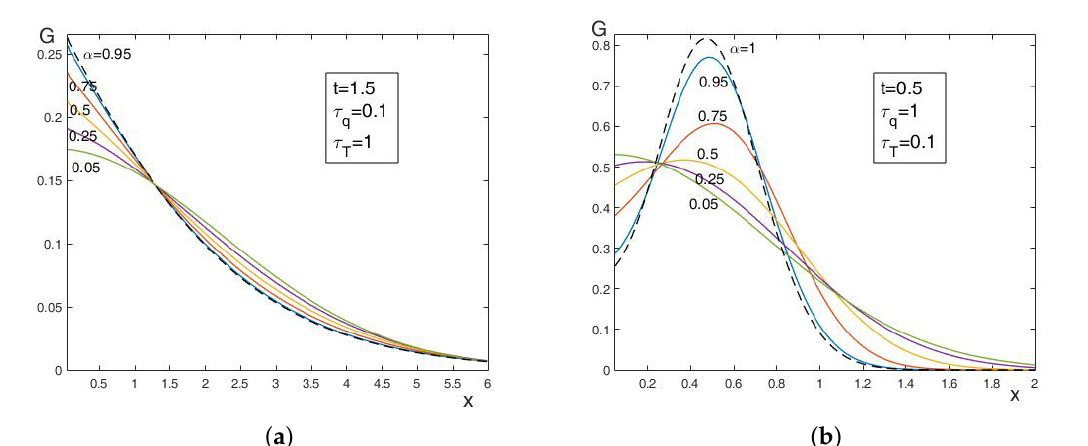
Figure 2. Plots of the the fundamental solution G 1 ( x , t ) versus x ( x > 0) for fixed t and different values of α , α = 0.05,0.25,0.5,0.75,0.95, compared to α = 1 (dashed line); ( a ) diffusion regime ( τ q < τ T );